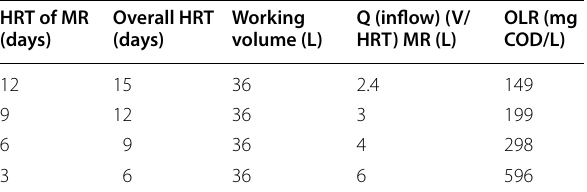
Table 1 Methanogenesis phase operating parameters of